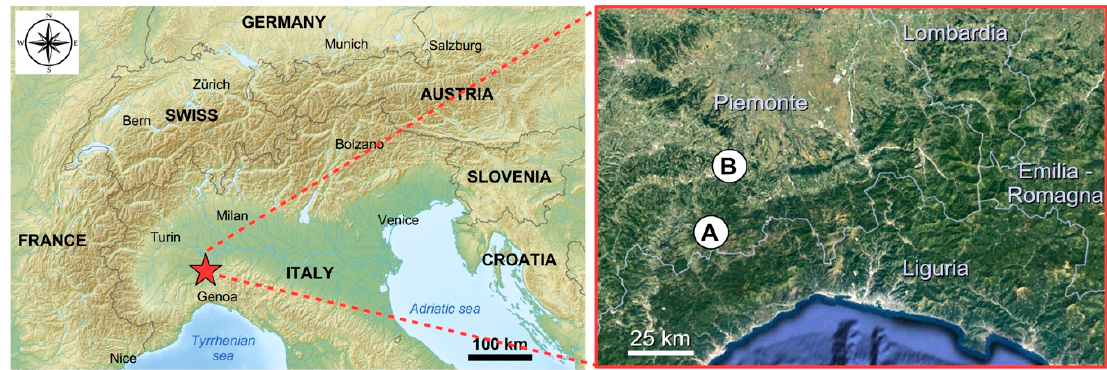
Figure 7. Localization of the two sampling areas: ( A ) hill (Ponzone); ( B ) plain (Visone).